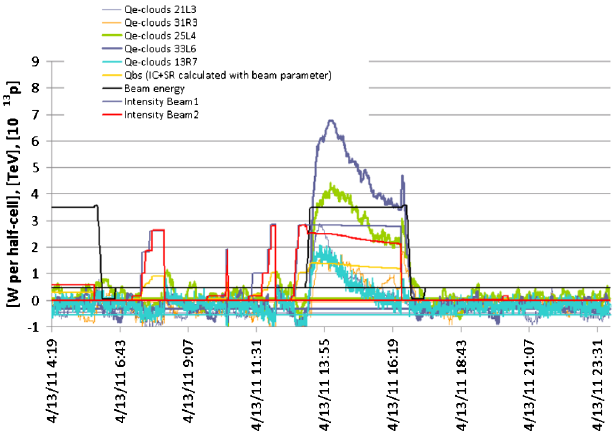
FIG. 7. Measured heat load due to the electron cloud during the scrubbing process at 50 ns at a beam energy of 3.5 TeV on 13 April 2011. Qbs refers to the computed heat load on the beam screen due to image currents and synchrotron radiation, whereas Qe clouds are the heatloads associatedtoelectroncloud indifferent locations, obtained by subtracting Qbs from the measured values.